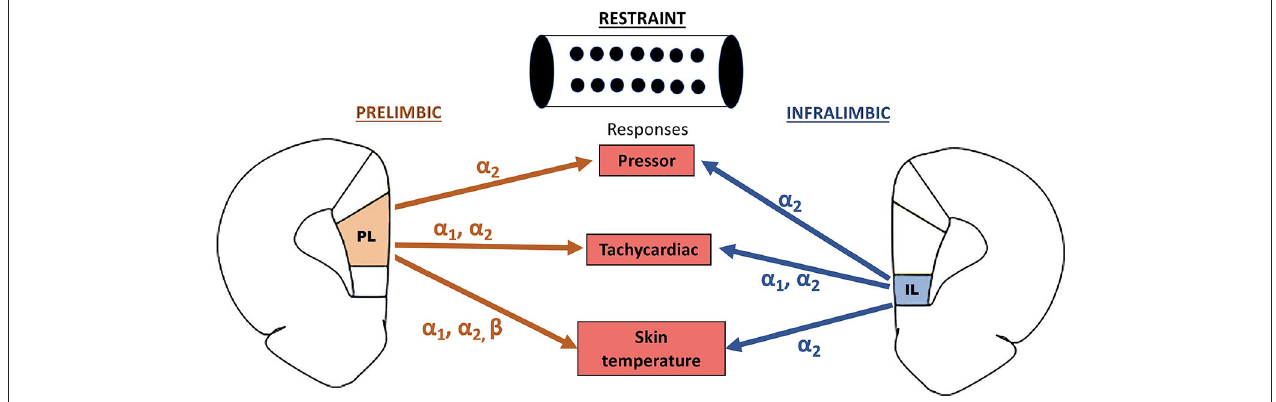
FIGURE 4 | Summary of the facilitatory control of restraint-evoked pressor, tachycardiac, and skin temperature responses by α 1 -, α 2 -, and β -adrenoceptors in the PL and IL subregions of the medial prefrontal